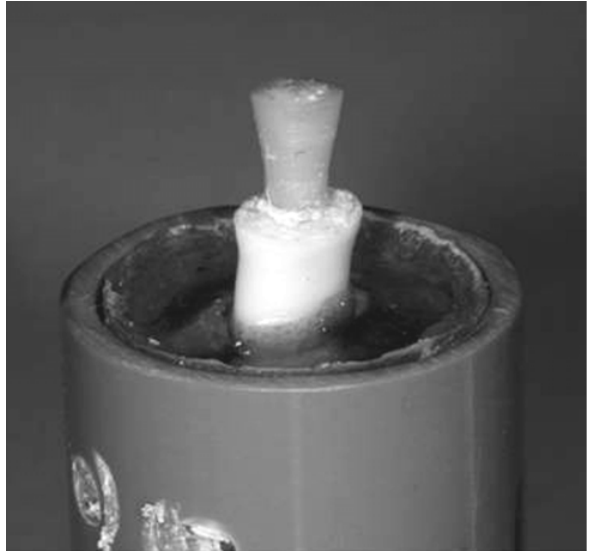
FIGURE 1- Specimen after post cementation and coronal